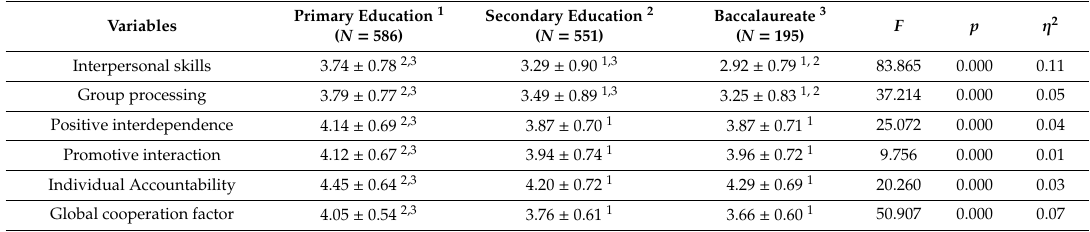
Table 6. ANOVA analysis of di ff erences in the cooperative learning dimensions according to educational